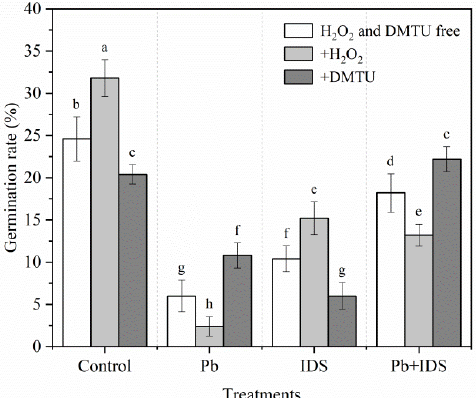
Figure 4. Effects of DMTU and H 2 O 2 on the germination of maize seeds treated with IDS, Pb, or their combination. Maize seeds treated with distilled water (control), Pb (20 mmol · dm − 3 PbCl 2 ), IDS (100 mmol · dm − 3 ), or Pb+IDS were further treated with DMTU or H 2 O 2 for 1 d. Error bars represent the standard deviation of the mean ( n = 5). Means associated with different letters are significantly different among treatments and time points ( p < 0.05; Duncan’s new multiple range test). Pb, lead; IDS, iminodisuccinic acid; DMTU, dimethylthiourea.